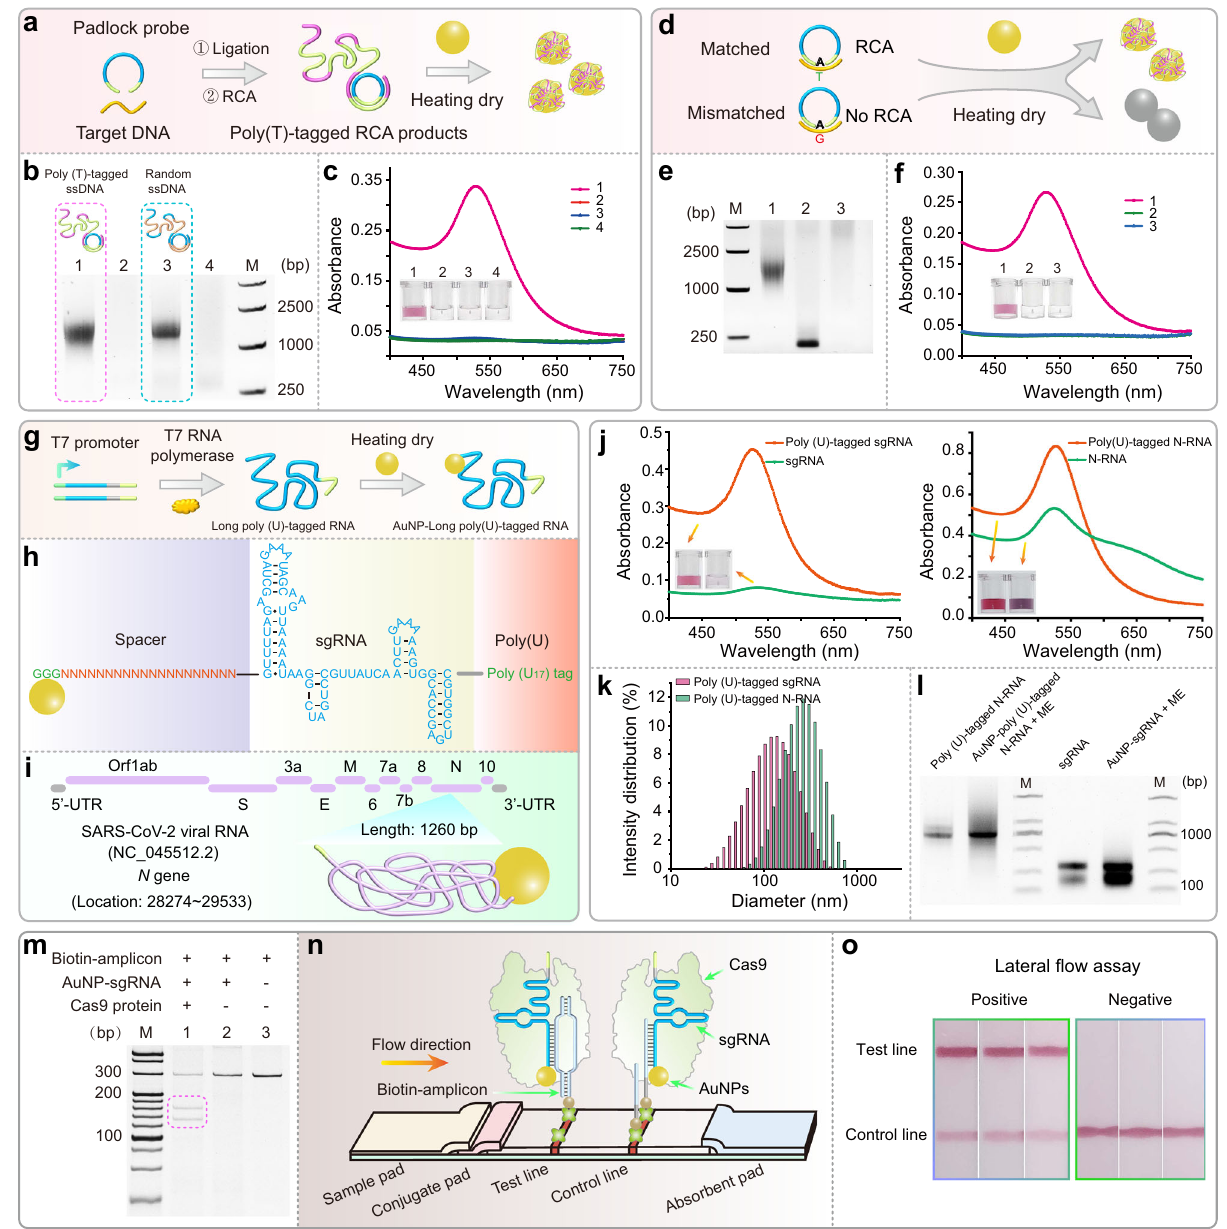
Fig. 6 MW-assisted heating-dry method enables labeling of long DNA and long-structured RNA and the application on biosensing. a MW-assisted heating-dry method for labeling RCA products containing interspaced poly (T) tag. b Gel electrophoresis analysis of RCA products. Lanes 1 and 3 represent the poly (T)-contained ssDNA and random ssDNA from RCA reaction. Lanes 2 and 4 are the control samples without target DNA template. c Photographs and the corresponding absorption spectroscopy data showing the labeling results of RCA products. d Development of colorimetric single-base mutation diagnosis based on ligation-dependent RCA reaction and MW-assisted heating-dry method. e Gel electrophoresis analysis of RCA products with perfectly matched or single-base mismatched target DNA. Mismatched target DNA will lead to failed ligation and RCA reaction. Lane 1 represents the RCA products with matched DNA, lane 2 represents the RCA reaction products with single-base mismatched DNA, lane 3 represents the control sample without target DNA. f Photographs and the corresponding absorption spectroscopy data showing the detection results. g Labeling of long-structured RNA with poly (U)- tagged sgRNA (136 bp) and long N-RNA (1278bp) was obtained using in vitro T7 transcription. The sequence, structure, and labeling details of sgRNA and N-RNA are shown in h and i , respectively. j Characteristic of labeling results of sgRNA and N-RNA using absorption spectroscopy. k Dynamic light scattering measurement of the AuNP-sgRNA and AuNP-N-RNA conjugates. l Gel electrophoresis analysis of the in vitro transcribed sgRNA and N-RNA, and sgRNA and N-RNA displaced from AuNPs surface by ME. m Electrophoresis analysis of the cleavage ability of the assembled Cas9/sgRNA-AuNP complex. n Development of CRISPR/Cas9-mediated test strip assay. Schematic illustration of the test strip based on the Cas9/sgRNA-AuNP probes. Cas9/sgRNA-AuNPs probes recognize the biotinylated DNA products and fl ow through the test strip. The resulting complexes of Cas9/sgRNA-AuNP probe and biotinylated DNA are retained by streptavidin on the test line. Excess Cas9/sgRNA-AuNP probes fl ow through the control line and are captured by the precoated ssDNA capture probes. o Photographs taken from Cas9-sgRNA-AuNP probes-based test strip assay for detection of B646L (VP72) gene from